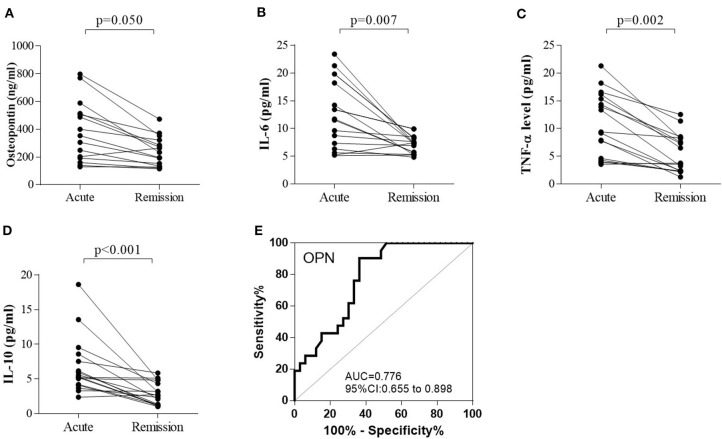
The changes in (A) cerebrospinal fluid osteopontin (CSF OPN), (B) interleukin (IL)-6, (C) tumor necrosis factor alpha (TNF-α), and (D) IL-10 in 15 anti-NMDAR encephalitis patients who were examined in both acute and remission stage. (A–D) The levels of OPN (p = 0.050), IL-6 (p = 0.007), TNF-α (p = 0.002), and IL-10 (p < 0.001) were all significantly decreased in the follow-up period compared with those in acute stage. Receiver operating characteristic (ROC) analyses of (E) CSF OPN between patients with anti-NMDAR encephalitis and controls. The area under the receiver operating characteristic (ROC) curve (AUC) of OPN was 0.776.